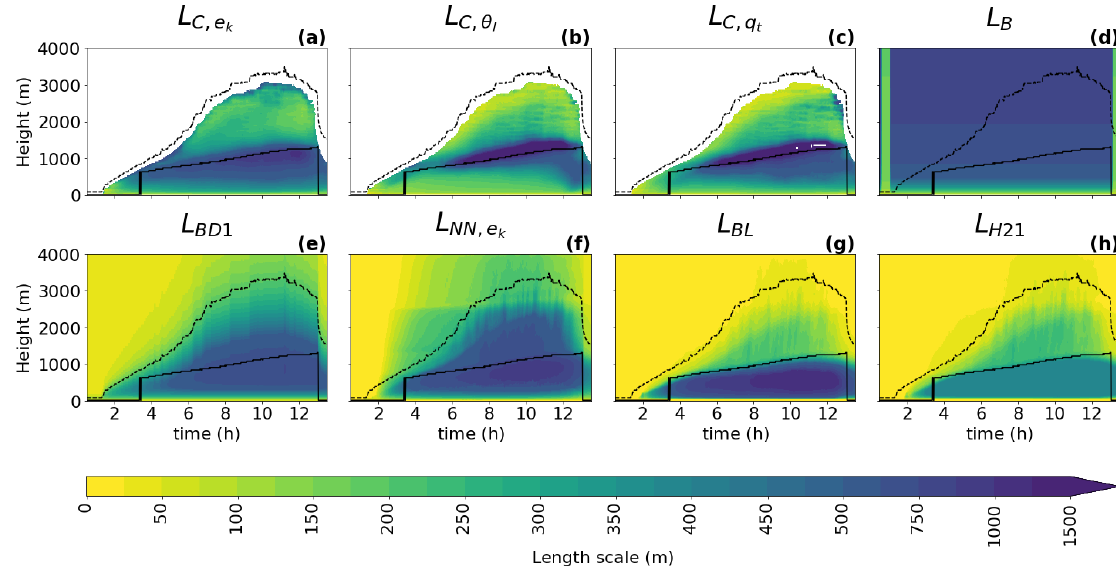
Figure 3. The temporal evolution of the turbulence length scale diagnostics: L C , e L C , Θ ( c ); and the turbulence length scale formulations: L B ( d ), L BD 1 ( e ), L NN , e l ( h ); for the ARM case. The length scales are computed for the second smallest sub-domain size ( N sd = 16 2 ). The evolution of the cloud base height and the boundary layer height are represented by the black solid and dashed lines,